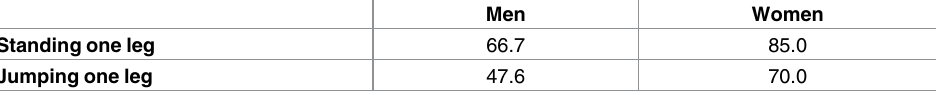
Table 2. Percentage of agreementbetween the dominant leg of the best bilateral mobilizing task (kick- ing a ball) with the unilateral stabilizing tasks.